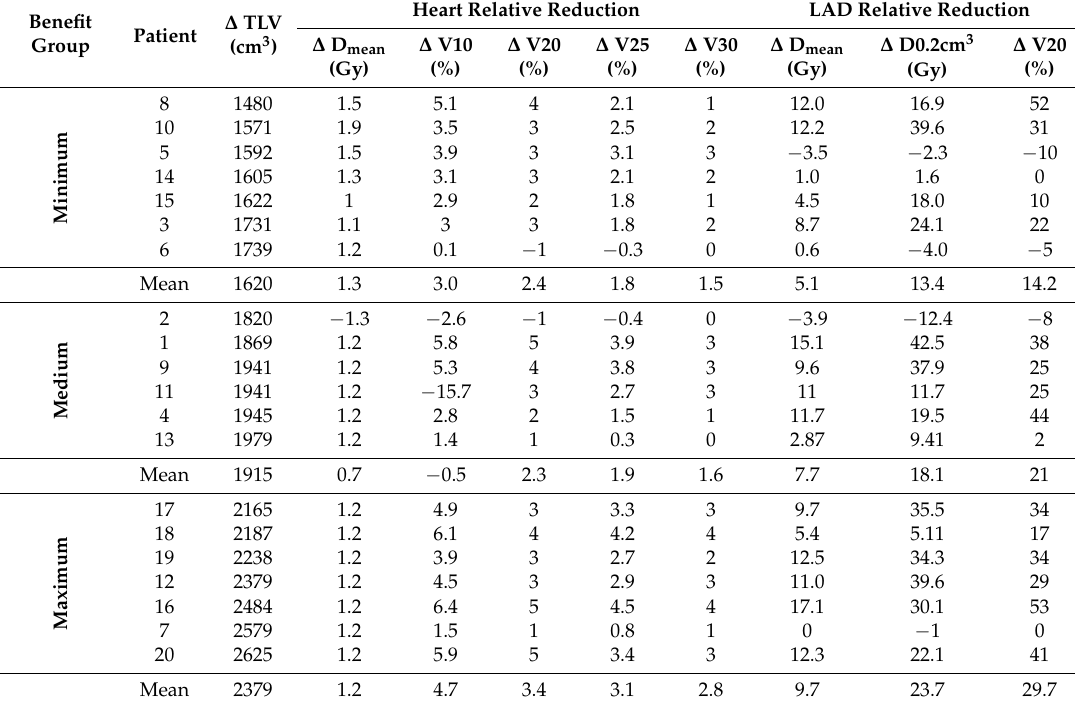
Table 6. Individual total lung volume between FB and DIBH plans ranked and grouped in ascending